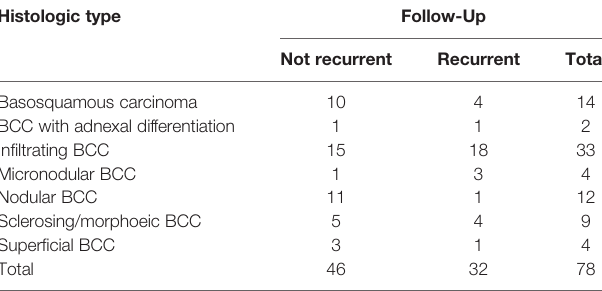
TABLE 6 | Crosstab of recurrence follow-up data by tumor